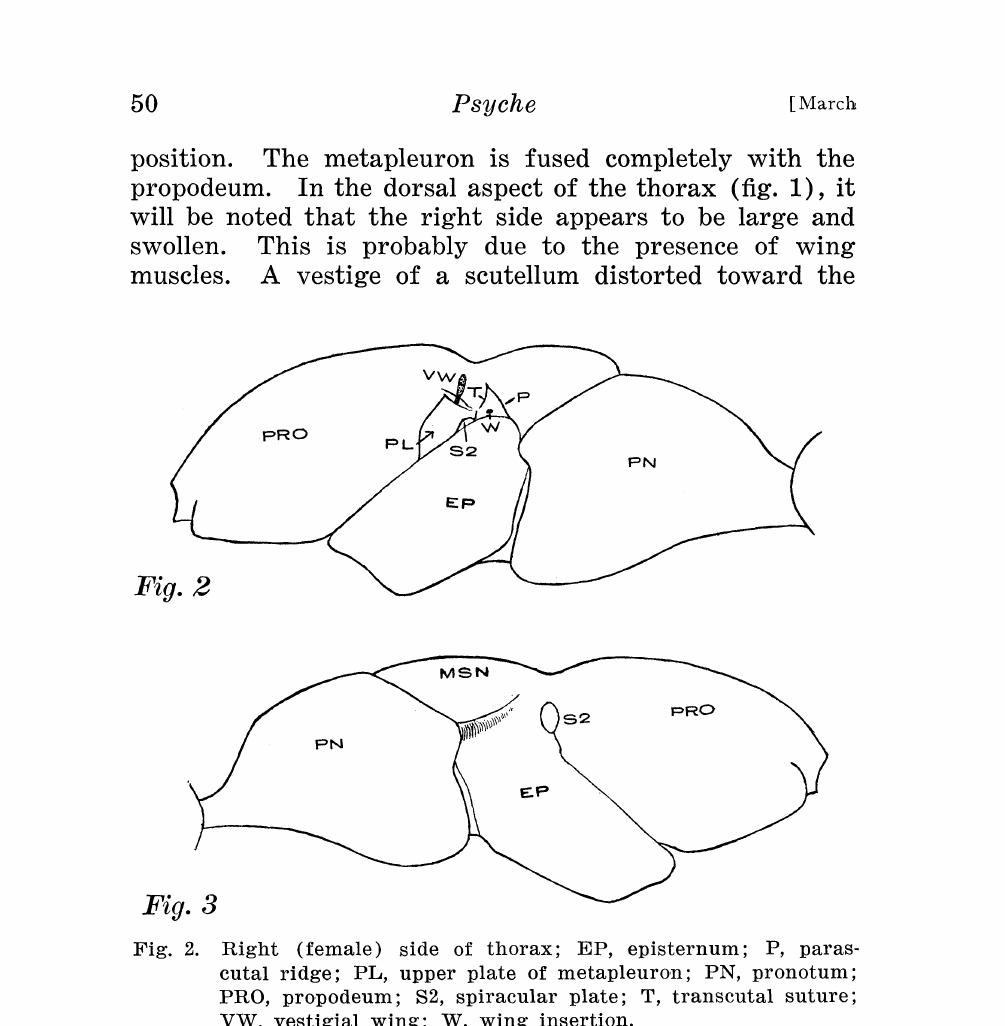
Fig. 2. Right (female) side of thorax; EP, episternum; P, paras- cutal ridge; PL, upper plate of metapleuro.n; PN, pronotum; PRO, propodeum; $2, spiracular plate; T, transcutal suture; YW, vestigial wing; W, wing insertion. Fig. 3. Left (worker) side of thorax; MSN, mesonotum.